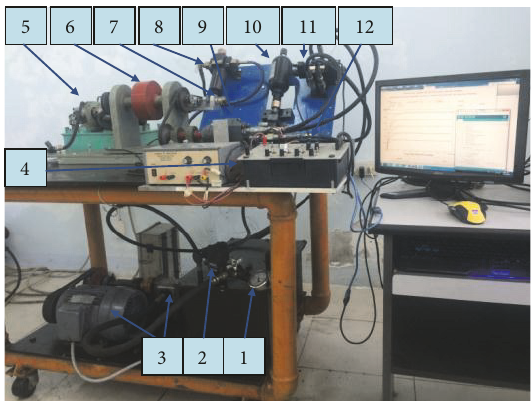
Figure 3: Picture of experimental system (1: pressure gauge; 2: overflow valve and safety valve (maximum pressure 31.10 6 N/m 2 , maxiumum flow rate 56.7l/min, Taiwan); 3: hydraulic power with three-phase motor (2.2kW, 1420 rpm) operating with the V-belt (transmission ratio is 1:1) to supply oil for gears (volume is 12 ∗ 10 −6 m 3 /rev; maximum pressure is 20 ∗ 10 6 N/m 2 ); flow rate supplying for the system is 17.04l/min; 4: amplification (Festo Didactic); 5: load generation system; 6: working shaft; 7: tachometer (Pittman USA, no F8412G591, 2V/Krpm); 8: high- pressure filter. Using to filter debris of oil (Parker, USA); 9: Hydraulic motor (12 ∗ 10 −6 m 3 /rad, Rockford illinois, Model 16-Z-3); 10: hydraulic accumulator (34 ∗ 10 6 N/m 2 , volume 0.95l); 11: proportional valve ( Q = 0 ÷ 2.33 ∗ 10 −4 m 3 /s, 𝑝 max = 15.98 ∗ 10 6 N/m 2 , 𝐼 max = 100mA, input